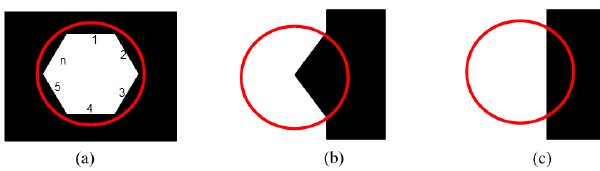
Figure 9. Typical derivatives of attenuators no. 1–4 as potentials to decrease the incident intensity. Panel (a) is a derivative of attenuator no. 2, which restricts the diameter of a beam with a polygon. Panel (b) is derivative of attenuator no. 3, which blocks a beam with an arc of sector. Panel (c) is a derivative of attenuator no. 4, which partly blocks a